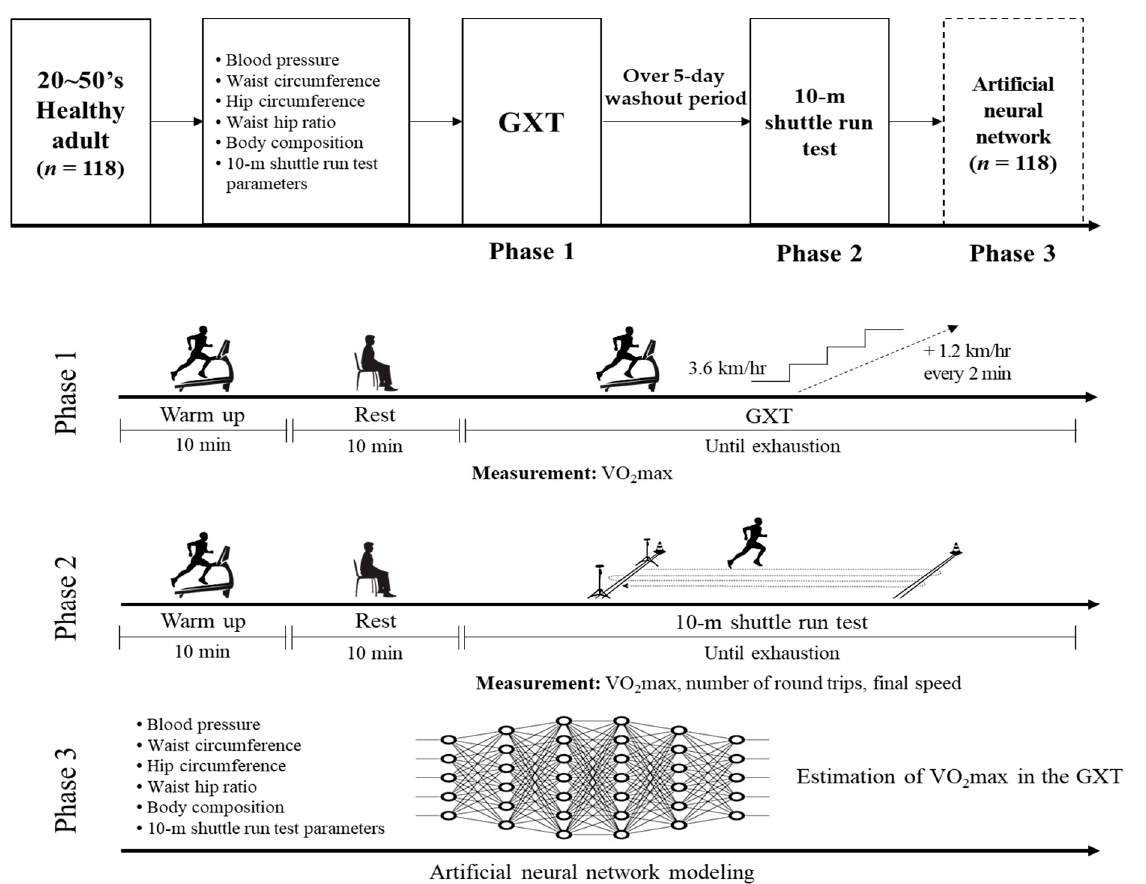
Figure 2. Study design. GXT, graded exercise test; VO 2 max, maximal oxygen uptake. Table 2. The 10 m shuttle run test protocol.